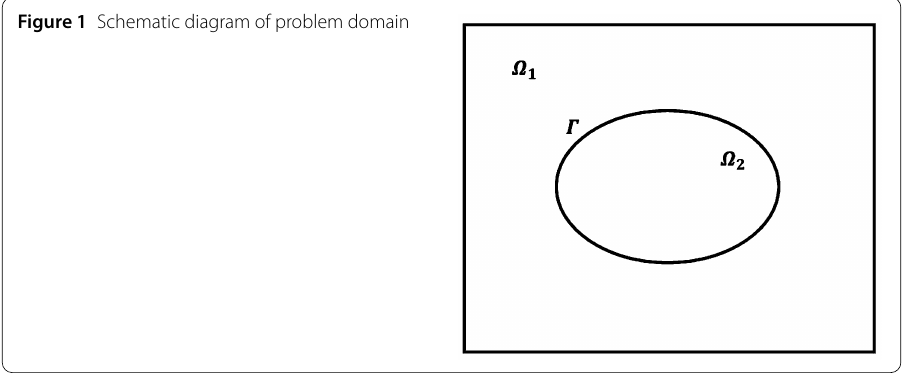
Figure 1 Schematic diagram of problem